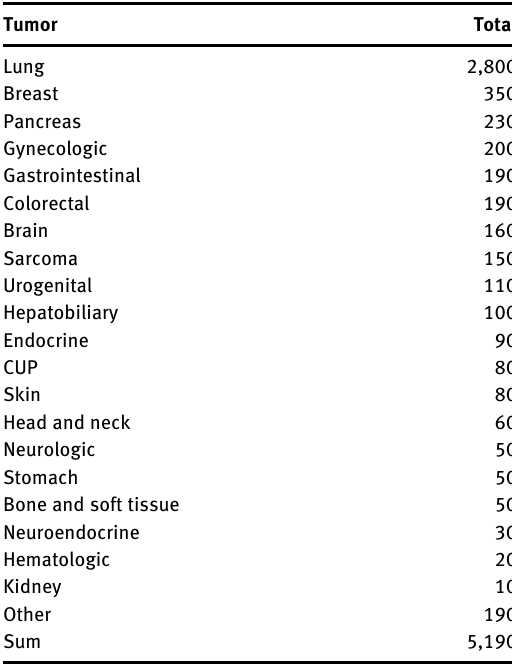
Table  : Cancer types of patients seen in molecular tumor boards at DKTK sites in 